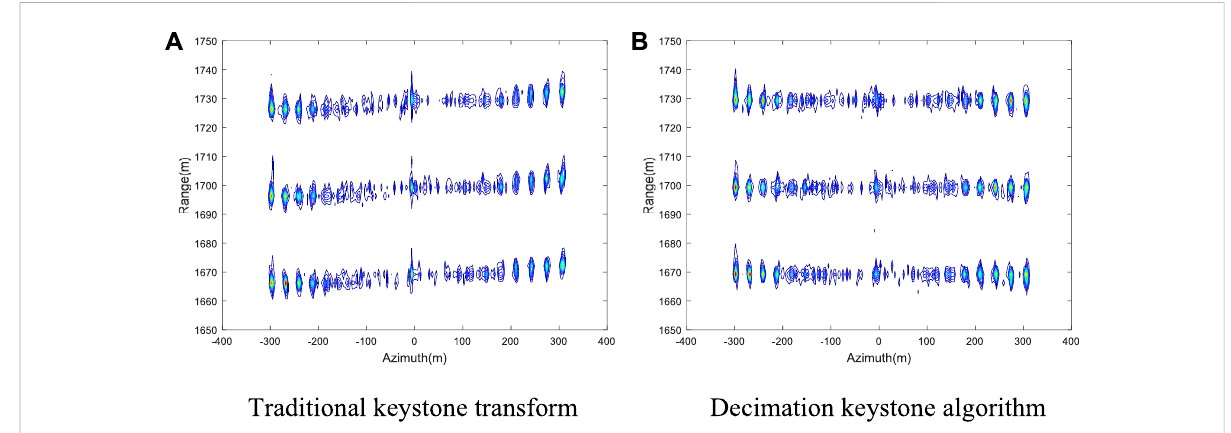
FIGURE 5 Comparison of image results of the uniform motion platform. (A) Traditional keystone transform. (B) Decimation keystone